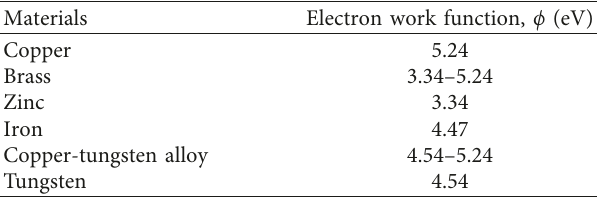
Table 1: Electron work function of common metals